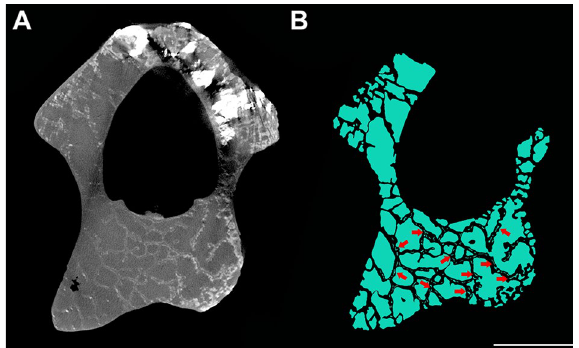
Figure 5. Internal air spaces in the condyle of the vertebra. Slice of the scan ( A ) and internal air spaces marked in blue ( B ) of the condyle of the seventh cervical vertebrae of SNSB/BSPG 1991 I 27. Red arrows indicate small hollow cavities within the bone trabeculae. Scale bar: 10